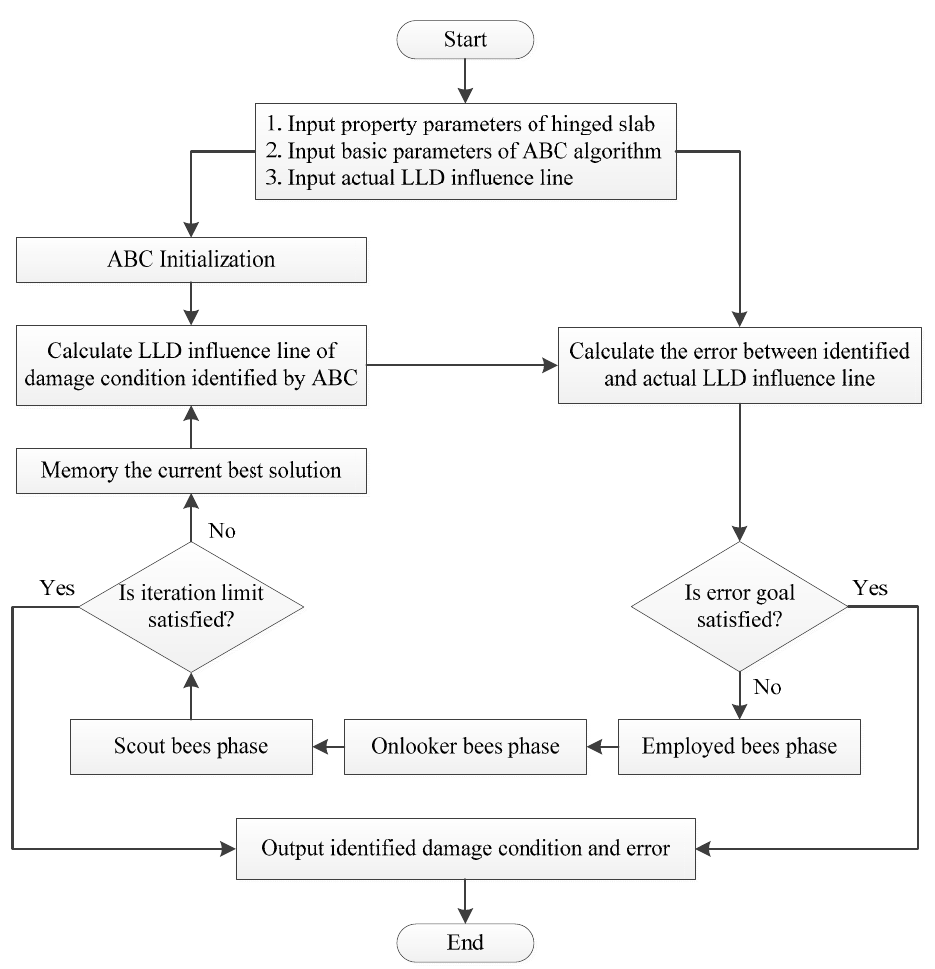
Figure 11. The flowchart of damage identification of hinge joint damage based on the artificial bee colony (ABC) algorithm.